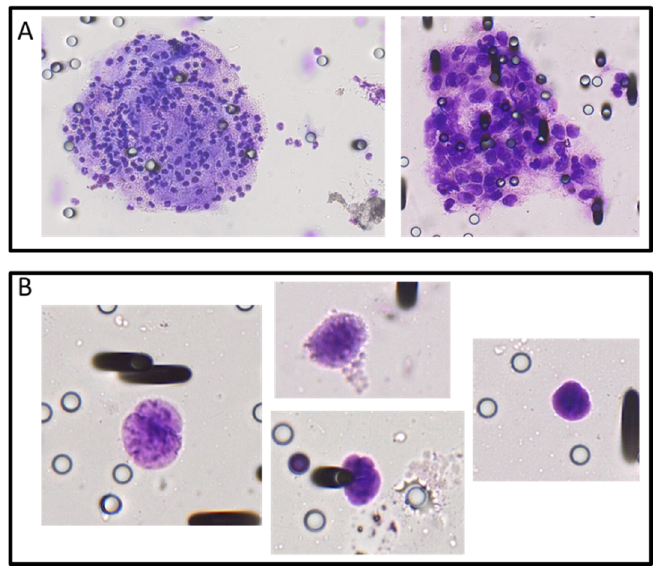
Appendix Figure A2. Aggregates ( A ) and identified circulating tumor cells ( B ) observed on ISET filters after the filtration of diagnostic leukapheresis product obtained from non-small-cell lung cancer patients. Staining was performed with Giemsa, and CTCs were identified by their large size, relatively large nucleus and other morphological characteristics by a certified